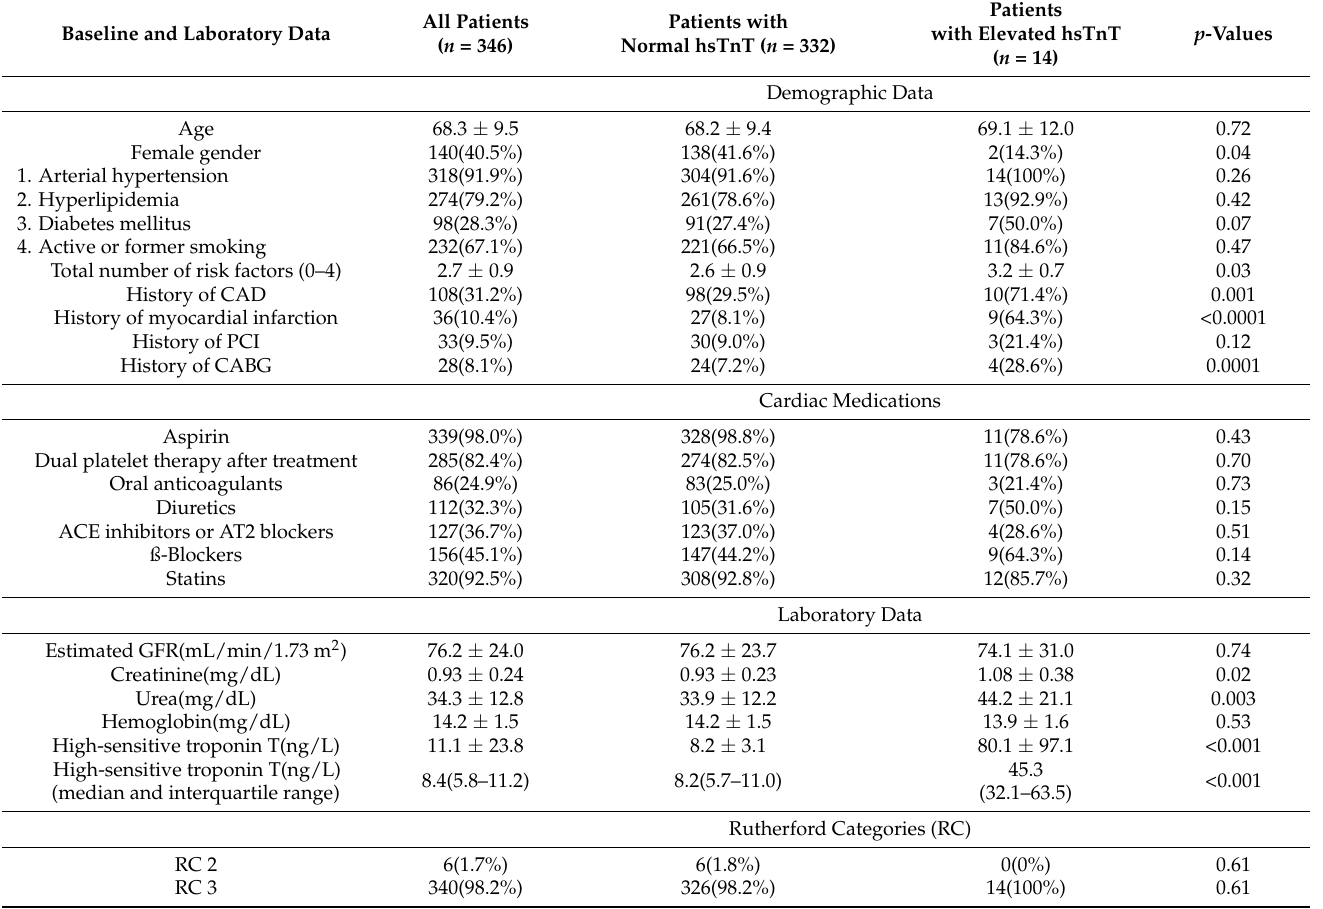
Table 1. Demographic data, laboratory markers and cardiac medications of patients with claudication and normal versus elevated baseline troponin